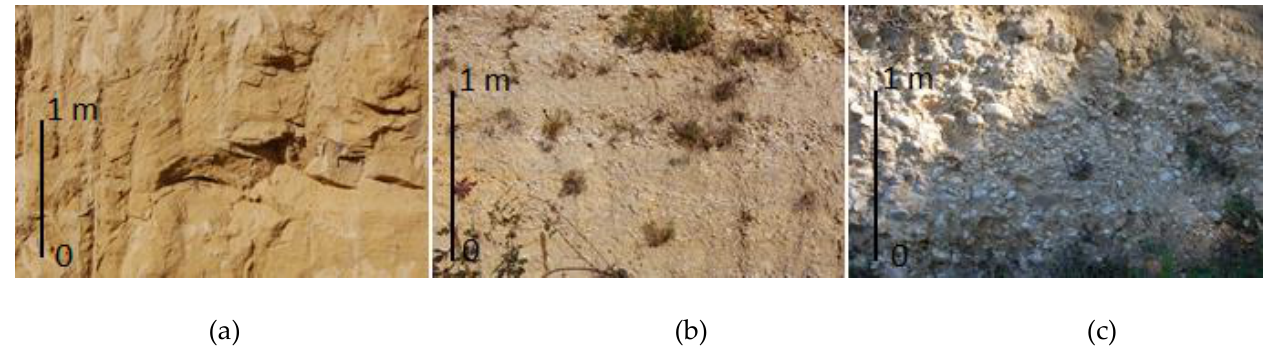
Figure 4. Some examples of sandy-gravelly association (Arenaceous complex), like they appear in outcrop; a): mainly arenaceous, b) arenaceous with gravel, c) mainly gravelly.